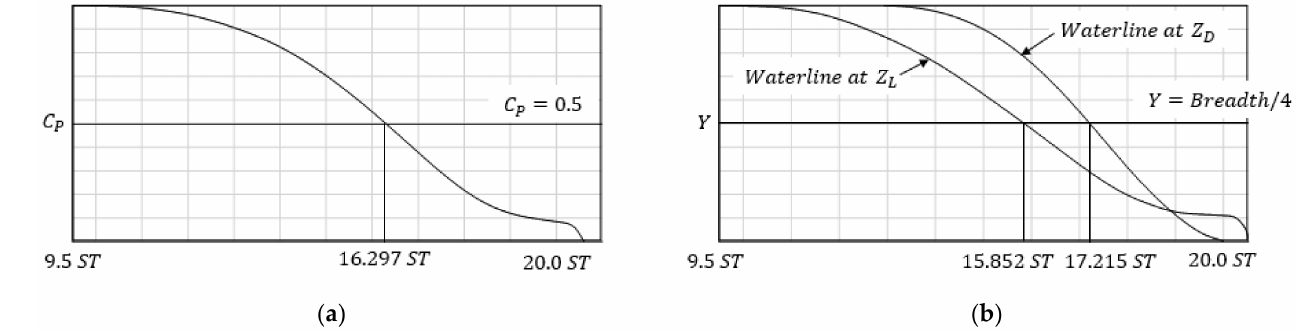
Figure 6. Definition of initial values for SQP. ( a ) SAC; ( b ) Waterline shapes at Z D and Z L .